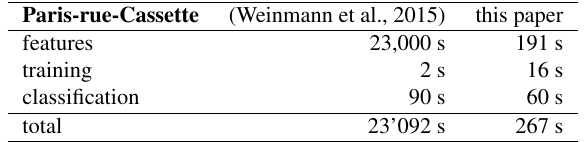
Computation times for processing the Paris-Rue- Cassette database an a single PC. Our feature computation is much faster. The comparison is indicative, implementation de- tails and hardware setup may differ, see